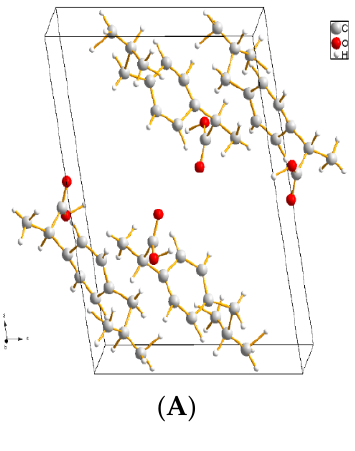
Figure 4. ( A ) Refined ibuprofen molecules from PXRD analysis and ( B ) quantitative phase analysis of DPI formulation FI, which was formulated with 2.5% IBF WPM, 2.5% leucine, 2.5% MgSt and 92.5% lactose carrier.